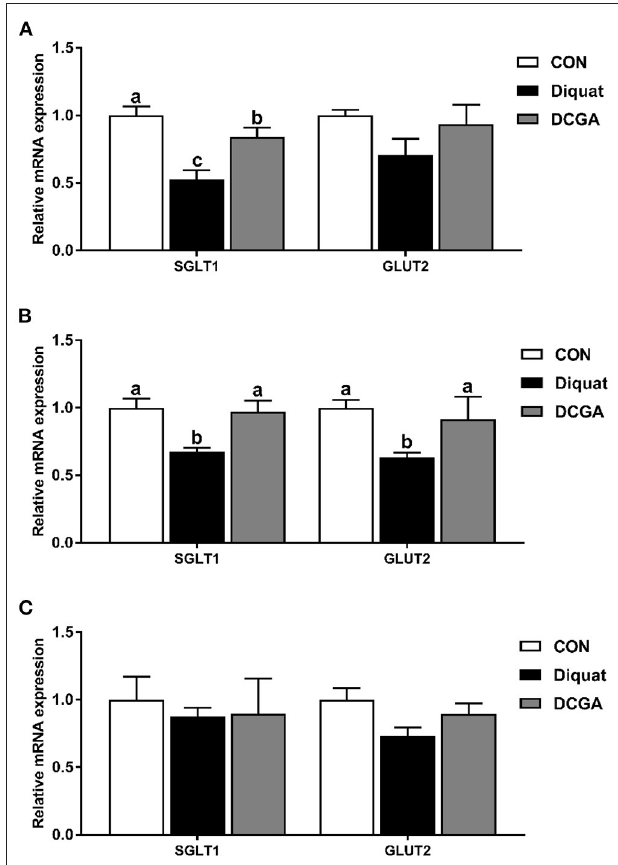
FIGURE 3 | Effects of CGA on expression levels of intestinal digestion and absorption-related genes in the Duodenum (A) , Jejunum (B) , and Ileum (C) . SGLT1, sodium glucose transport protein-1; GLUT2, glucose transporter-2; CON, piglets fed a basal diet; Diquat, piglets fed the basal diet and challenged by diquat; DCGA, piglets fed the basal diet containing CGA (1,000 mg/kg) and challenged by diquat. a,b Bars with different letters between treatment groups indicate significant differences ( P <